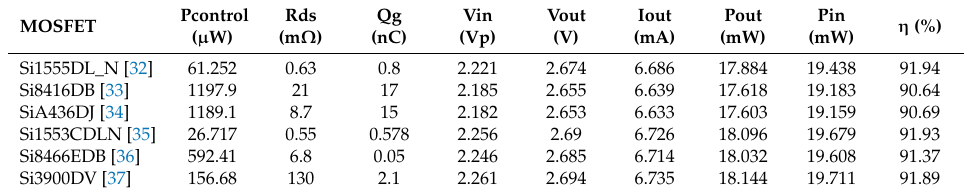
Table 4. Comparative results between different MOSFETs at 0.1 sun and 5 ◦ C.